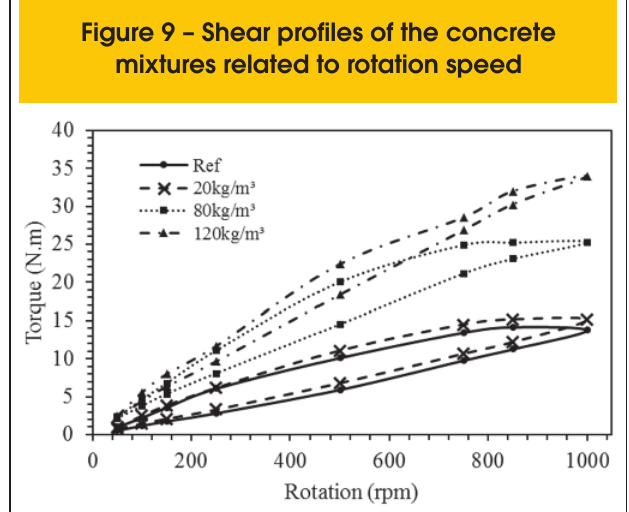
Figure 9 – Shear profiles of the concrete mixtures related to rotation